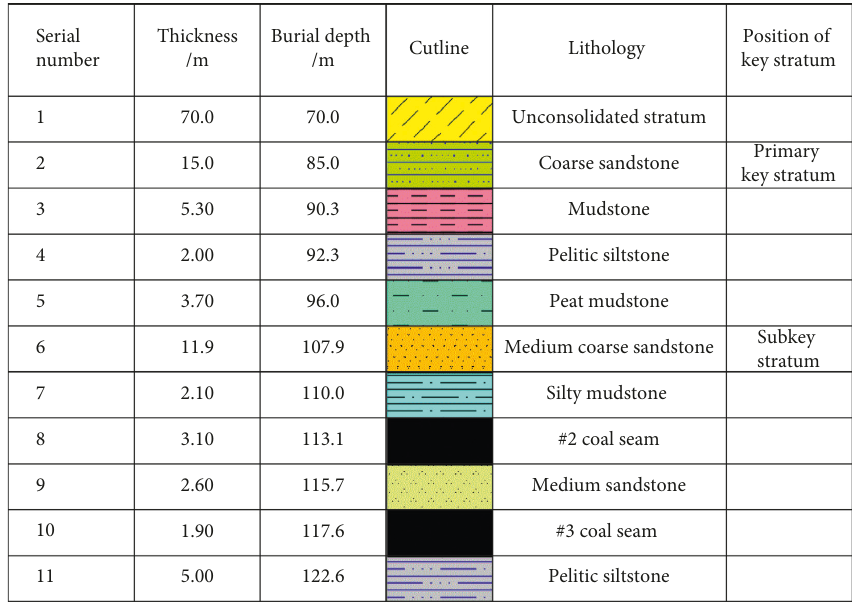
Figure 3: Borehole histogram of the coal